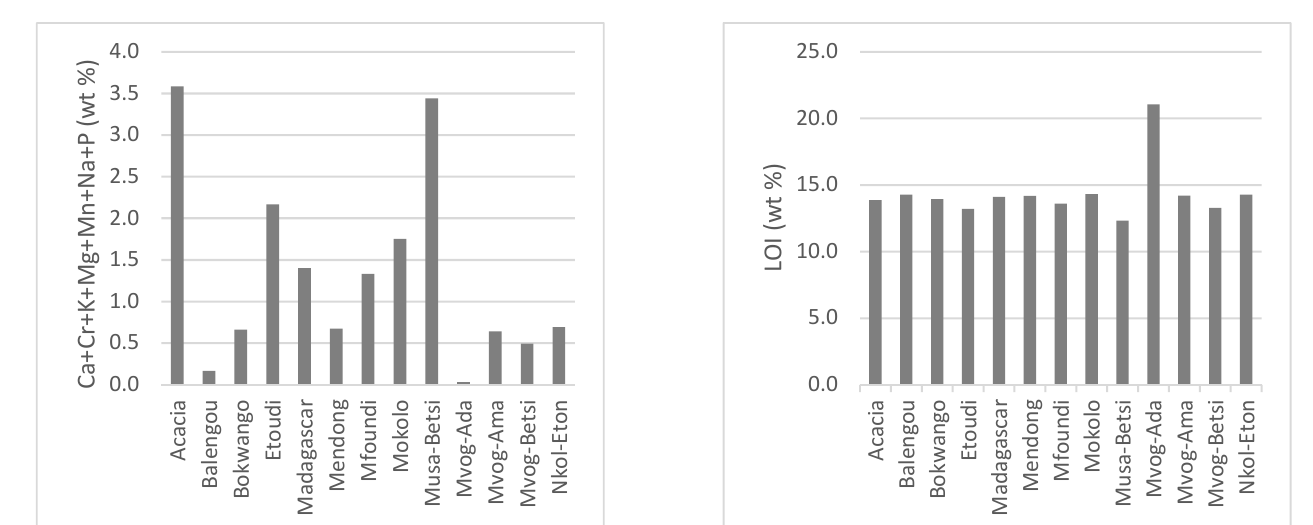
Figure 4. Concentration of major oxides, minor oxides and LOI in the studied geophagic clays.